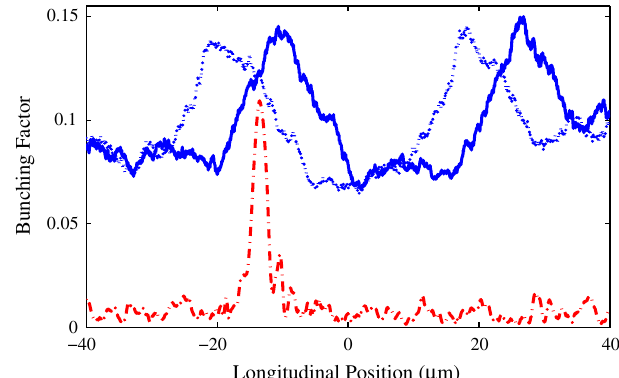
FIG. 8. Wide bandwidth bunching for two simulations with a 0.01 (cid:10) phase shift (solid and dotted blue lines). An FEL would pick out a narrow (cid:2) (cid:5)=(cid:5) ¼ 0 : 15% bandwidth, leaving lower bunching (narrow peak, red dot-dashed line). To calculate the bunching factor at a position z 0 and bandwidth (cid:2) (cid:5)=(cid:5) , we sum the phases of all particles in the region z 0 (cid:1) (cid:5)= 2(cid:2) (cid:5) < z < z 0 þ (cid:5)= 2(cid:2) (cid:5) . The high baseline in the wide bandwidth curves is due to the relatively low number of particles per bunching calculation when (cid:5)= (cid:2) (cid:5) is small. A bunched sine wave makes a sawtooth that may either be right leaning, as in Fig. 5, or left leaning, depending on the sign of the effective dispersion, R ð T Þ 56 . In our simulation, R ð T Þ 56 changes as a function of longitudinal beam position, resulting in the double peak seen in the wide bandwidth